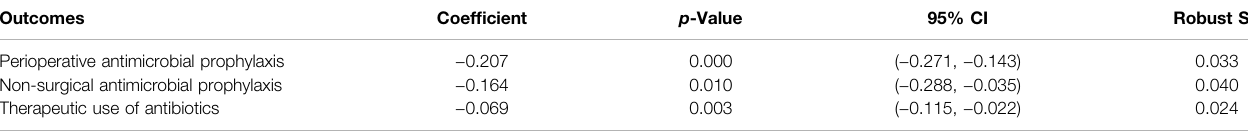
TABLE 6 | DID analysis of average score for both groups during the pre-intervention and post-intervention periods. Outcomes Perioperative antimicrobial prophylaxis